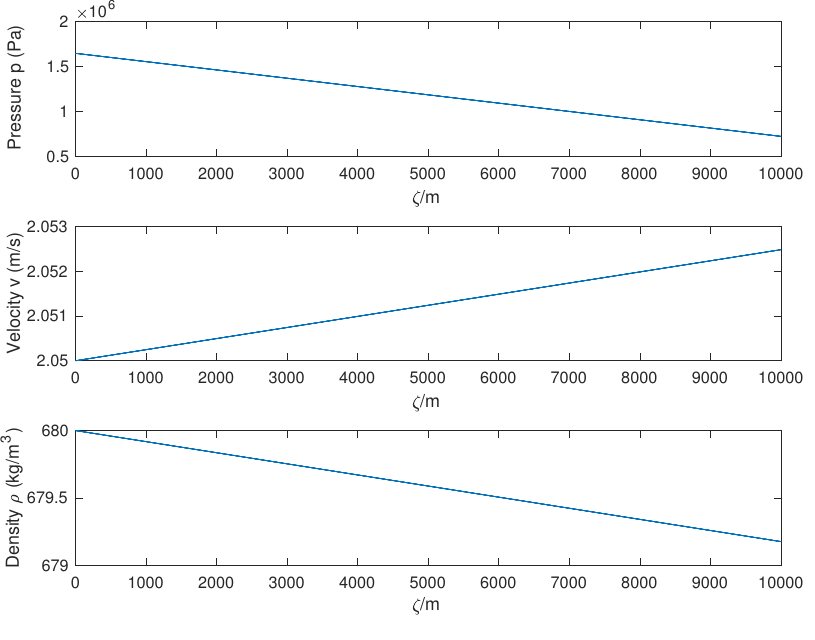
Figure 2. Profiles of steady states given by Equations